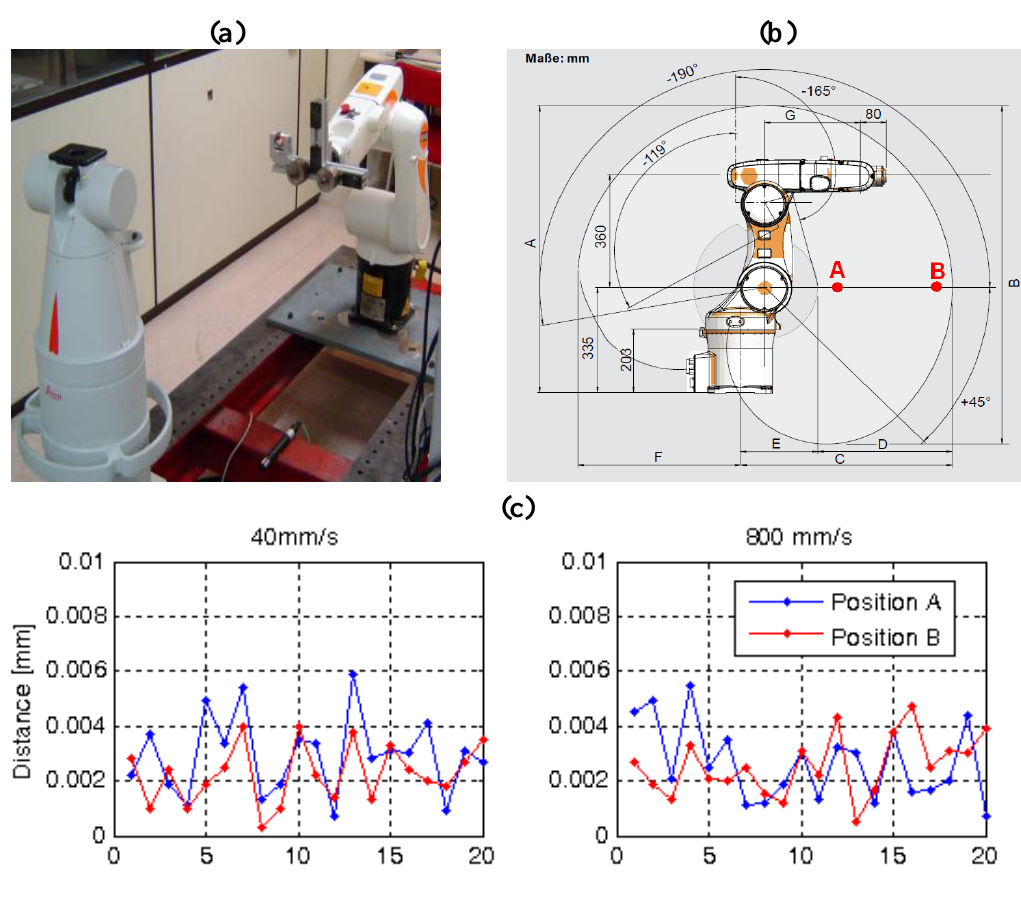
Figure 14. Repeatability test. (a) Laser tracker and robot during the test. (b) Schematic situation of points A and B. (c) Repeatability test results: distance between the position reached in each iteration and the mean position calculated with the twenty